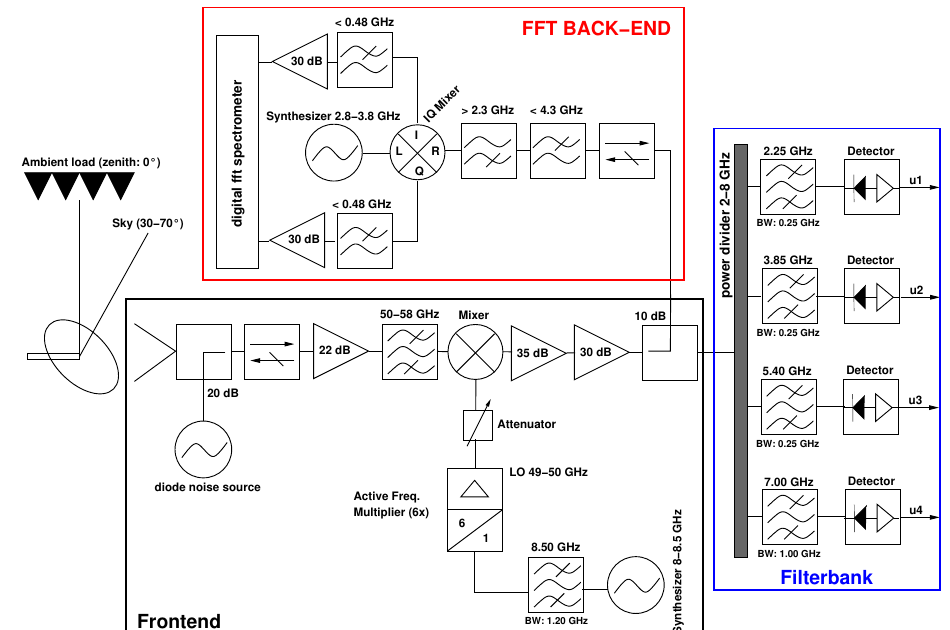
Fig. 1. TEMPERA block